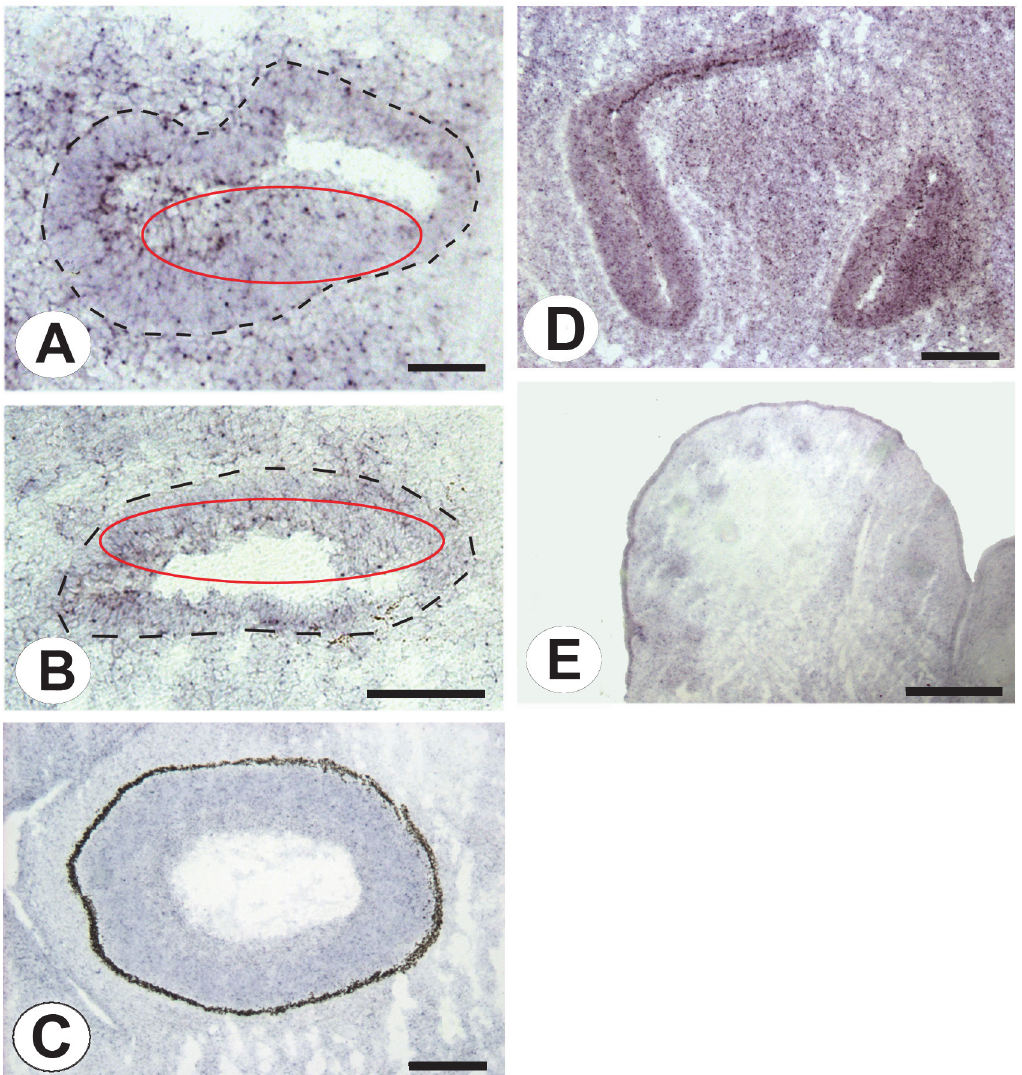
Fig 7. Crebbp expression in the five sensory organs. Kölliker's organ (A), Utricle (B), Retina (C), Olfactory organ (D) and Vibrissae (E). The dashed lines delineate the basal cochlear canal containing Kölliker's organ (A) and the utricle (B). Red ellipses identify the sensory regions. Scale bars: A, 50 μ m; B, 100 μ m; C, 200 μ m; D, 200 μ m; E, 500 μ